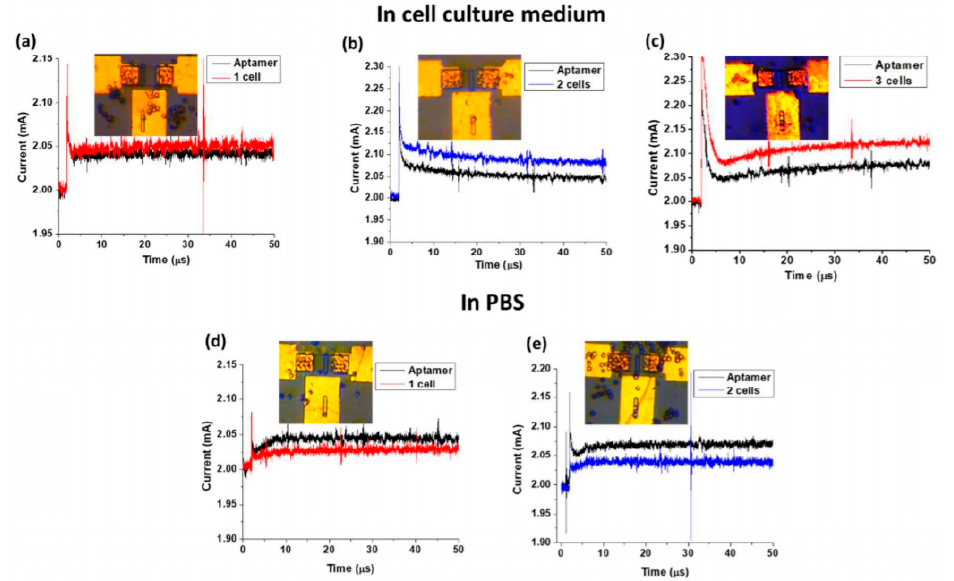
Figure 14. Detection and enumeration of circulating tumor cells in culture medium ( a – c ) and in phosphate buffer saline (PBS) ( d , e ). The cells captured on the device are clearly visible as brown circles. Adapted from Pulikkathodi et al. [76], with permission of The Royal Society of Chemistry.